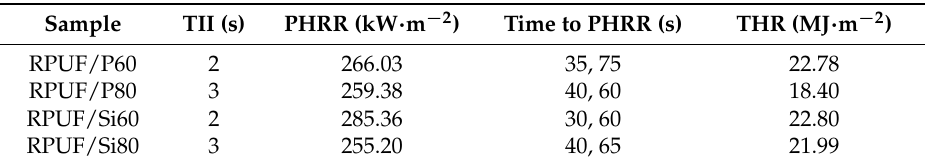
Table 6. Cone calorimeter testing data for RPUF.